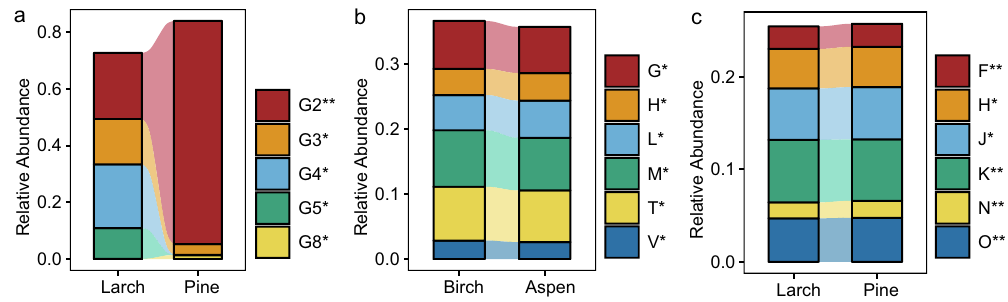
Figure 2. Soil microbial function. Facets a-c shows function guilds ( a ) and categories ( b , c ) meet following criteria: with known function; relative abundance > 0.01 in a certain forest; with significant difference relative abundance between some two forests. Asterisks marks the significant difference in relative abundances at levels: * p < 0.05; ** p < 0.01. Abbreviations of function guilds and categories are showed as follows. G2: